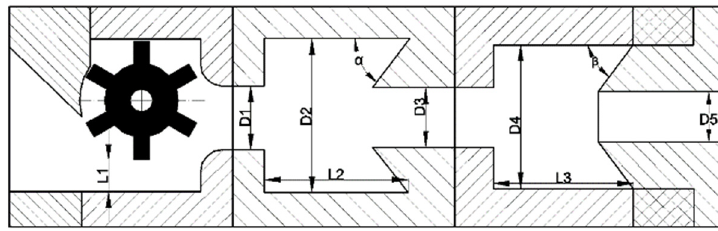
Figure 2. The geometric model of the runner structure.